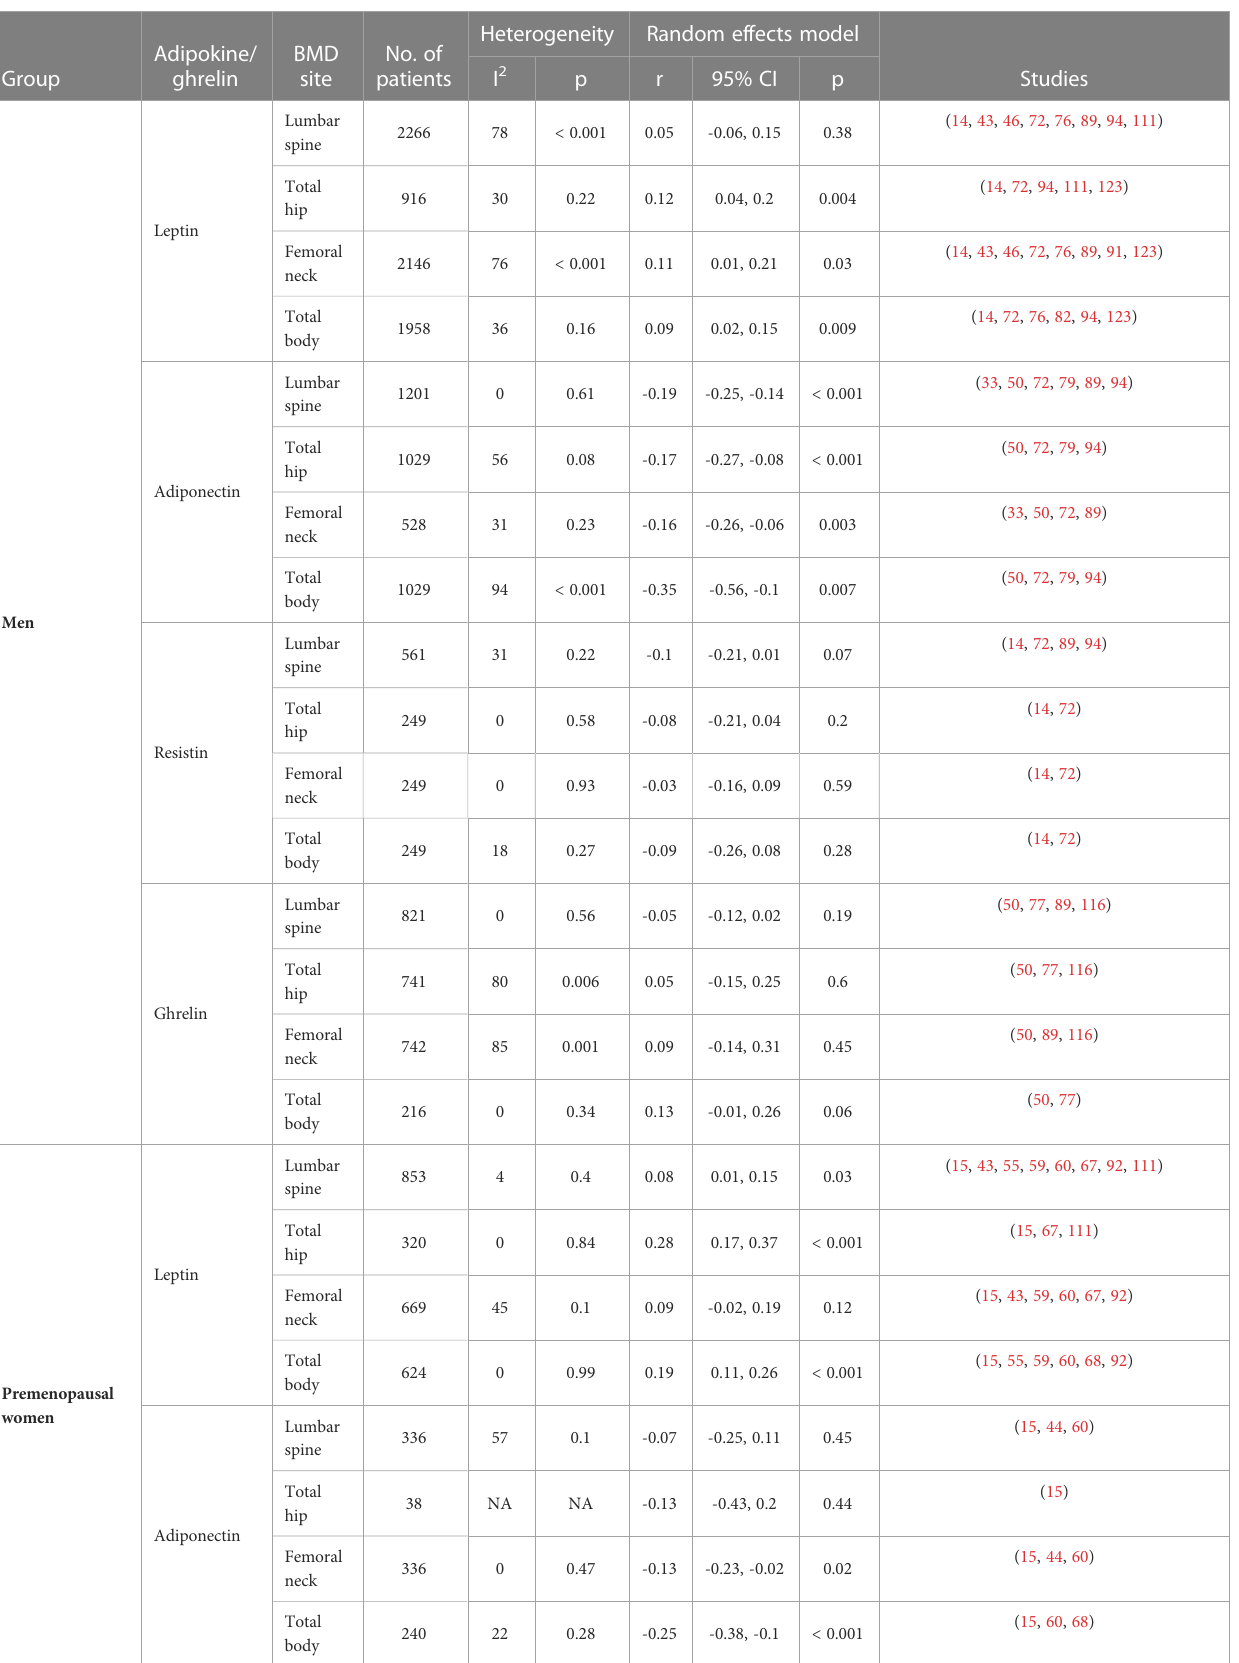
TABLE 1 Pooled correlations between adipokines or ghrelin level and BMD according to sex and menopausal status.